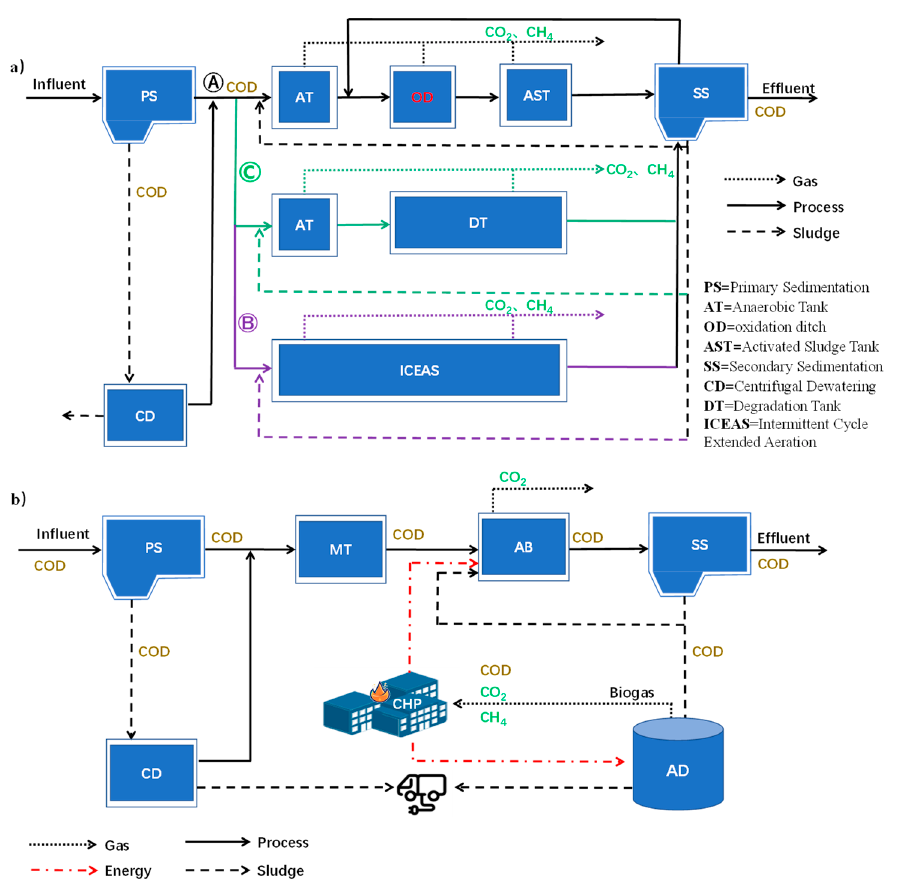
Figure 3. Energy flow and gas emission diagram of improved A 2 /O oxidation ditch process, process flow ( a ): Ⓐ WWTP A of Kunming, Ⓑ WWTP B of Kunming and Ⓒ WWTP C of Kunming, pro- cess flow, energy flow and gas emission diagram of Strass wastewater treatment plant in Austria ( b ).